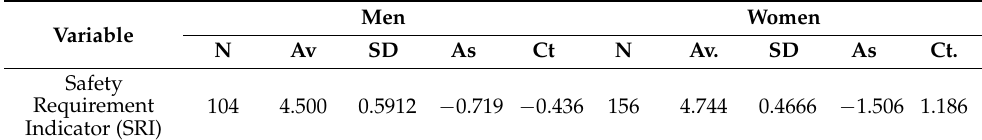
Table 3. Descriptive